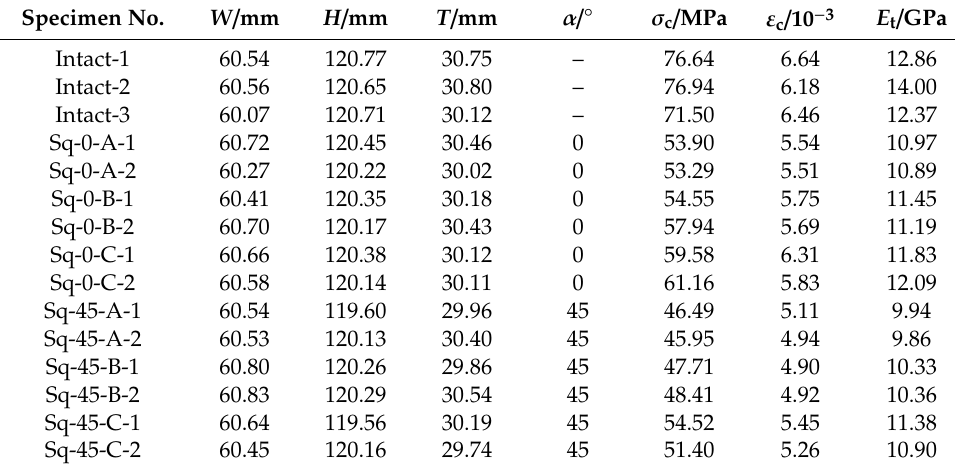
Figure 1. Geometry of the pre-holed specimens and filling modes. Table 2. Geometrical sizes and mechanical parameters of specimens.